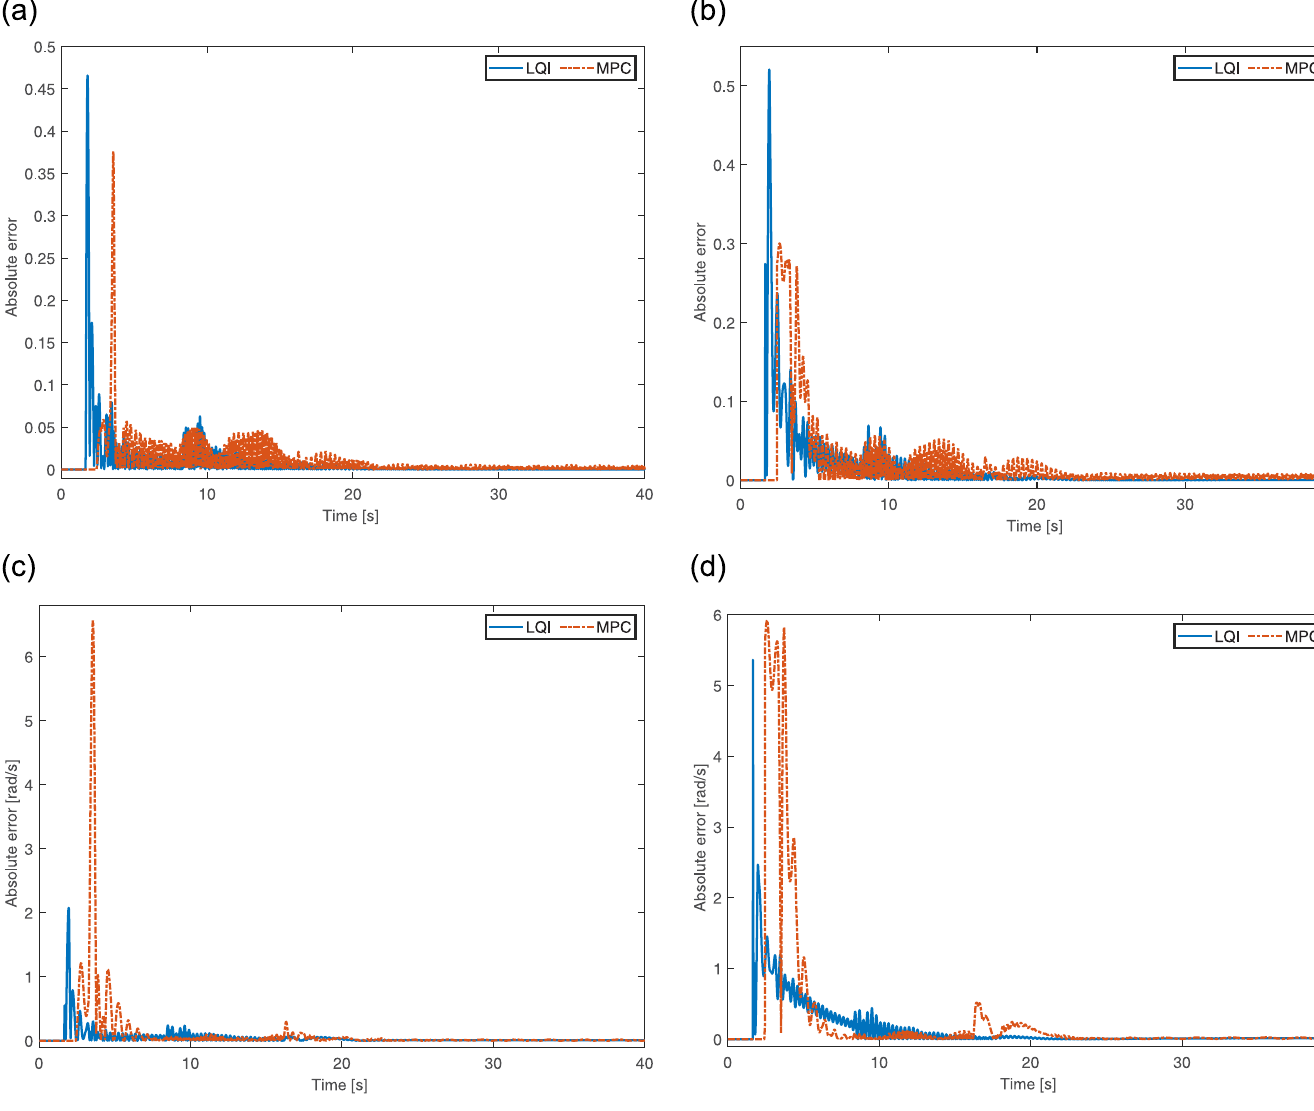
Fig 6. Reduced attitude error of the quadrotor for One propeller failure. (a) Absolute error in primary axis for η x . (b) Absolute error in primary axis for η y . (c) Absolute error in angular velocity for p . (d) Absolute error in angular velocity for q